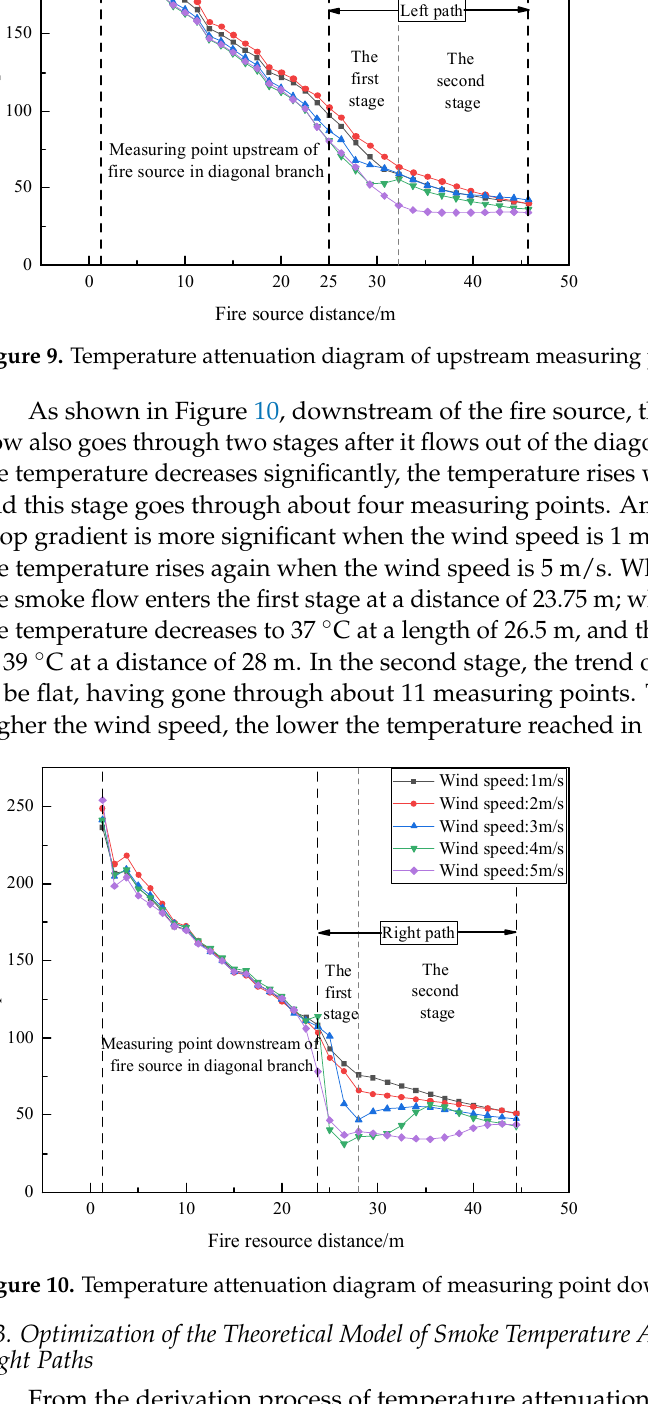
Figure 10. Temperature attenuation diagram of measuring point downstream of fire source.